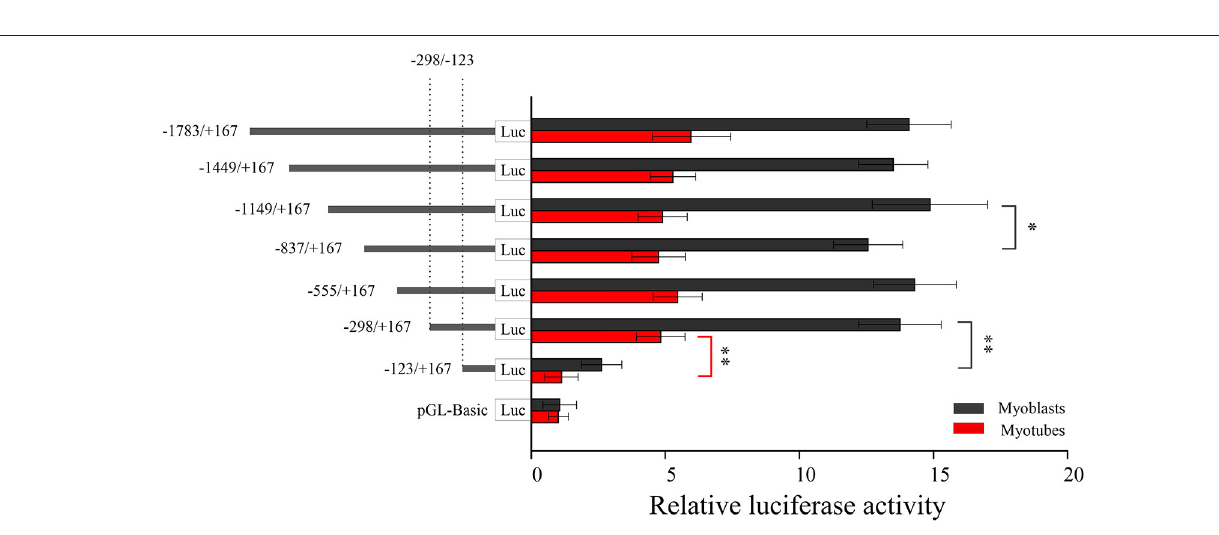
20.4 ( p < 0.05) and 38.9% ( p < 0.01) ( Figure 5B ). In